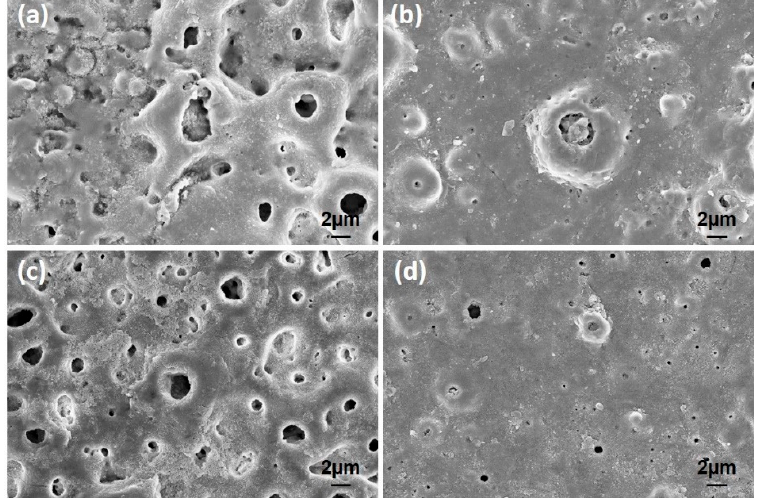
Figure 11. The surface SEM images of the coatings after corrosion tests in SBF: ( a ) free – GNS, ( b ) 0.5, ( c ) 1.0, and ( d ) 1.5 wt% GNS doped coatings.